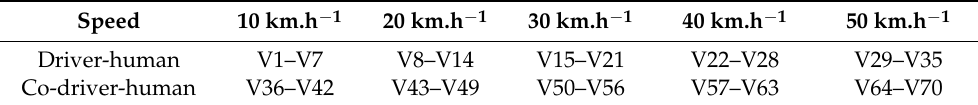
Figure 2. Schematic distribution of obstacles on the road. Table 1. Variants of the measurements.